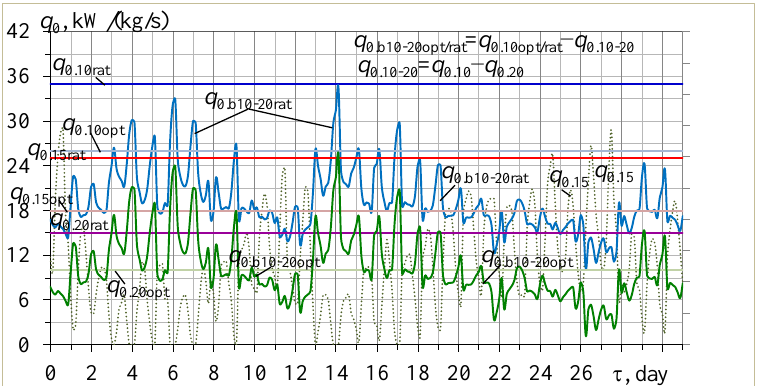
Figure 6. Actual values of refrigeration capacities q 0.15 needed for conditioning outdoor air to 15 °C, and booster refrigeration capacities q 0.b10-20opt and q 0.b10-20rat based on the optimal and rational design values q 0.10opt and q 0.10rat for conditioning outdoor air to 10 °C: q 0.b10-20opt = q 0.10opt − q 0.10-20 ; q 0.b10-20rat = q 0.10rat − q 0.10-20 .